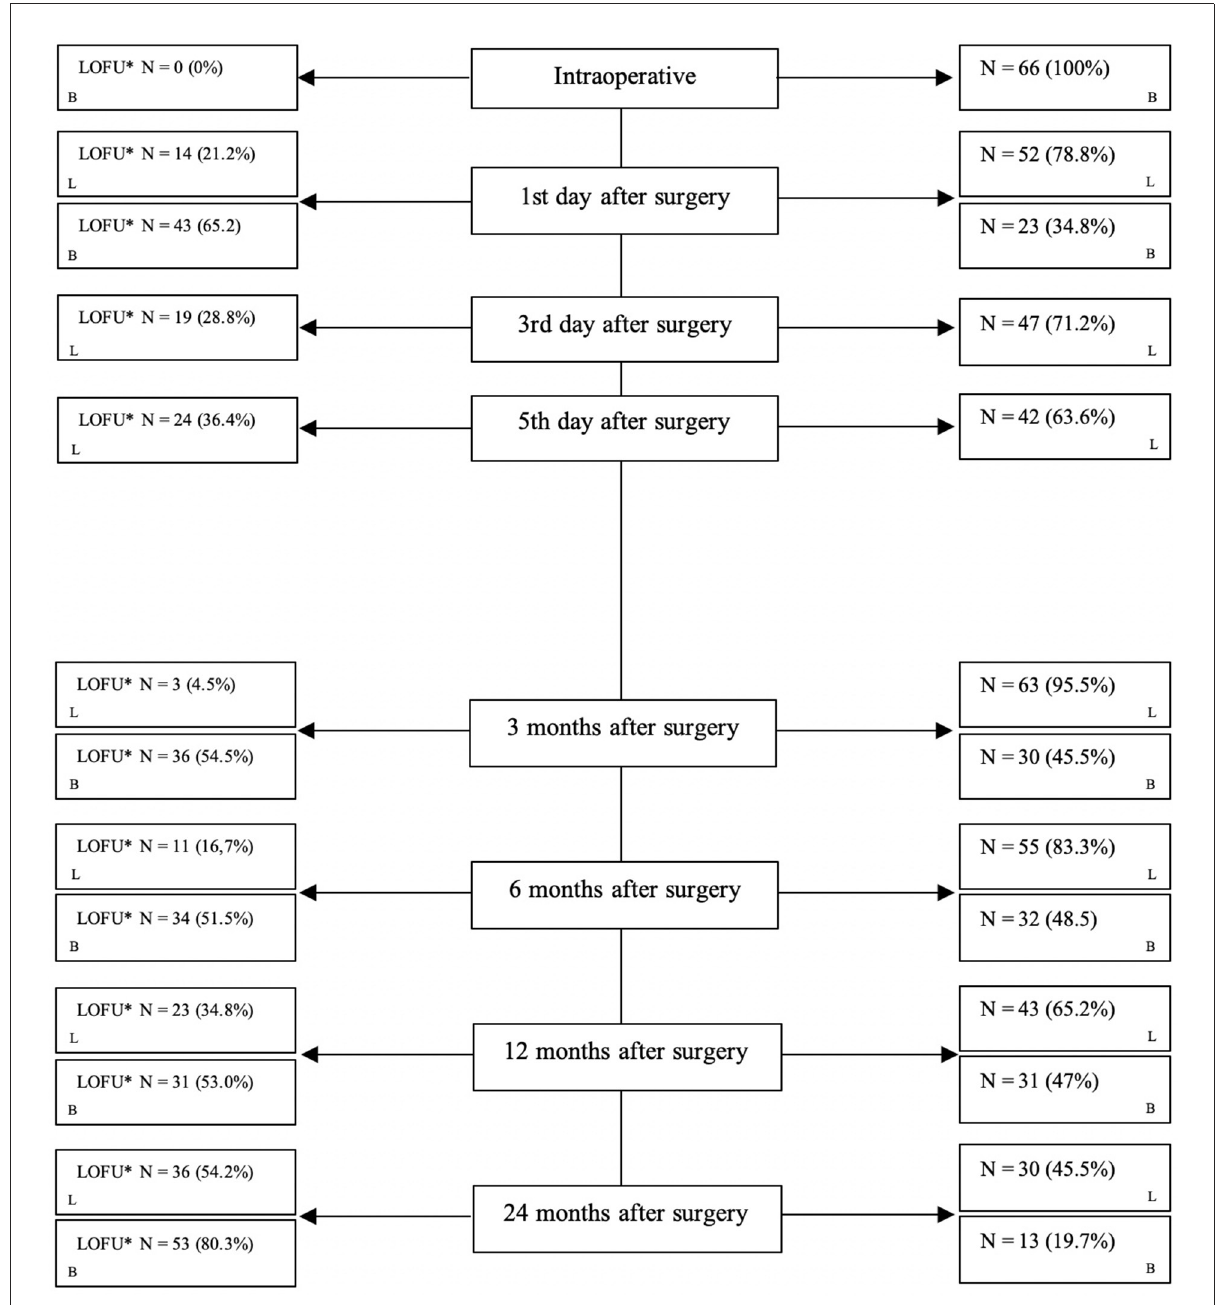
FIGURE1 Loss to follow-up during each step. *LOFU, loss to follow-up; N, number; L, laboratory value; B, bacterial swabs.